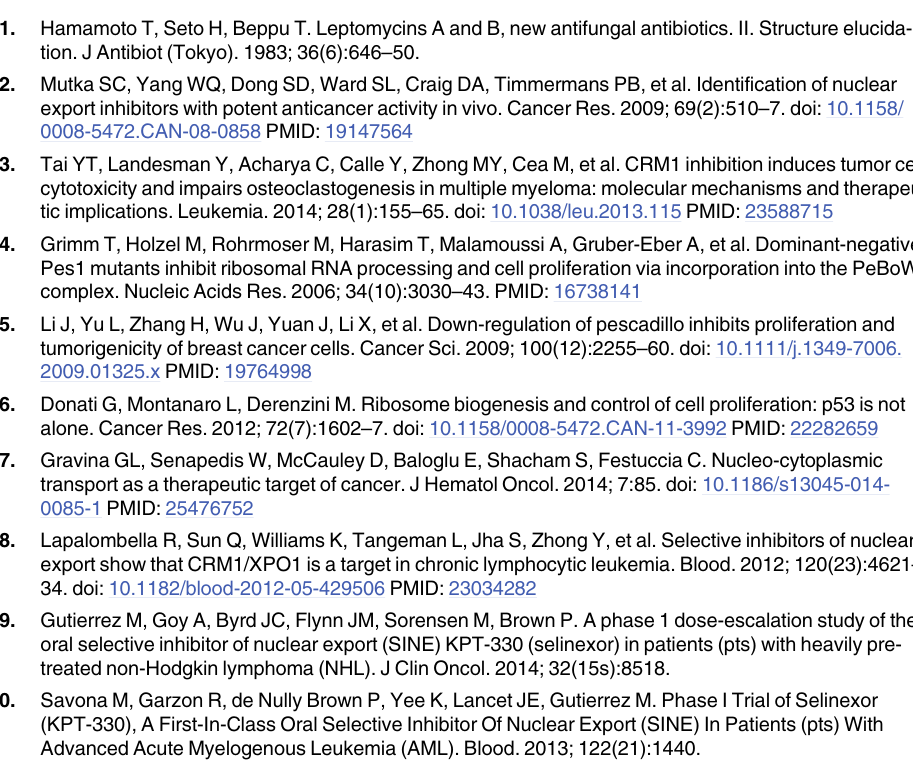
PLOS ONE | DOI:10.1371/journal.pone.0137210 September 4,